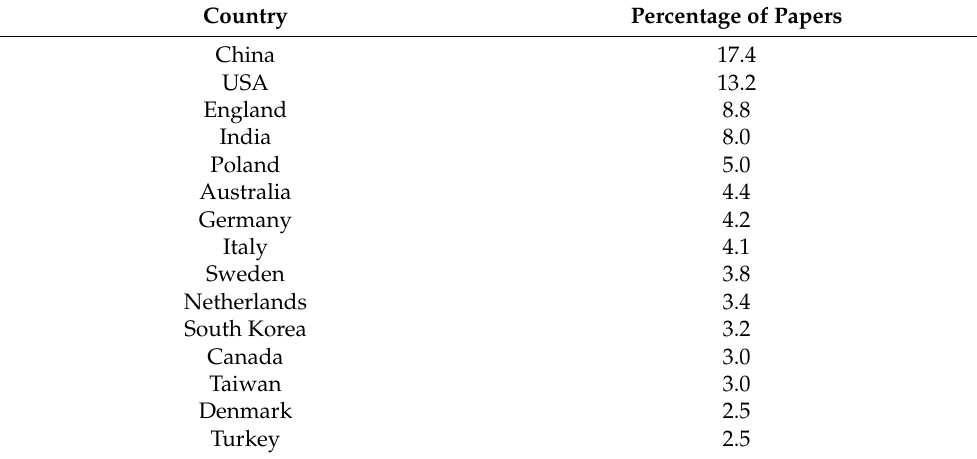
Table 5. Number of publications by country.